Question: Provide a publication-style caption for this figure.
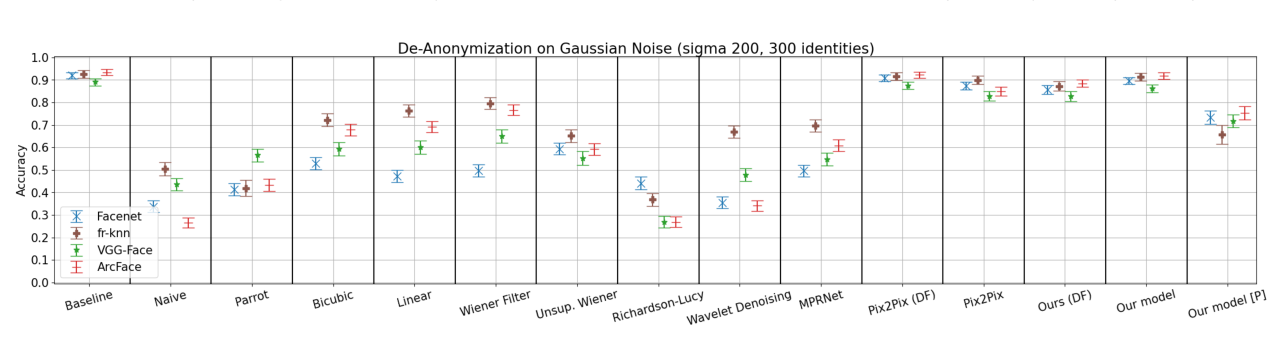
Answer: Recognition accuracy for Gaussian Noise, given for baseline, naive, parrot, de-anon. via bicubic interpolation, via linear interpolation, via Wiener Filter, via unsupervised Wiener Filter, via Richardson-Lucy interpolation, via Wavelet Denoising, via MPRNet (Denoising), via Pix2Pix trained on DigiFace-1M, via Pix2Pix, via our model trained on DigiFace-1M, via our model; on 300 identities of CelebA.